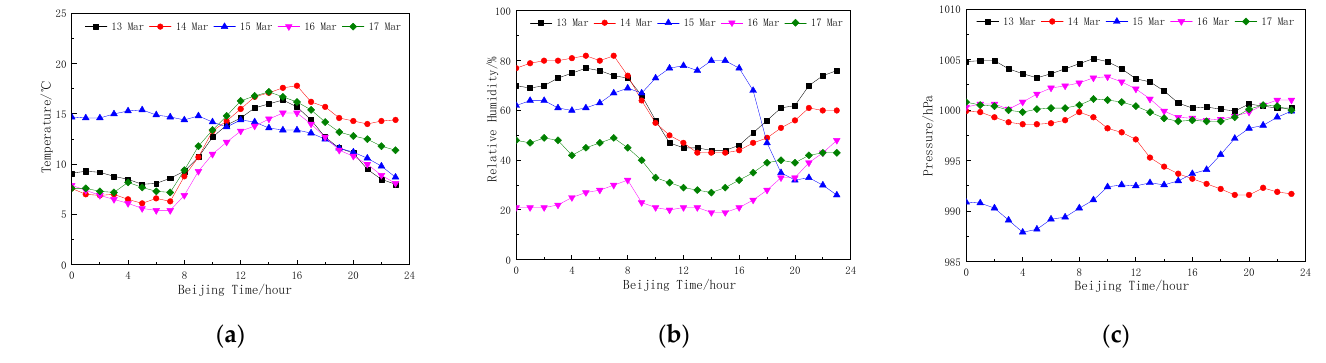
Figure 15. Variation curve of surface weather constituent ( a – c ) with time. To sum up, pressure decreases in the early stage of dust, while the RH decreases after dust. In the process of dust weather, it becomes cold during the day and warm at night, and the diurnal variation in temperature is